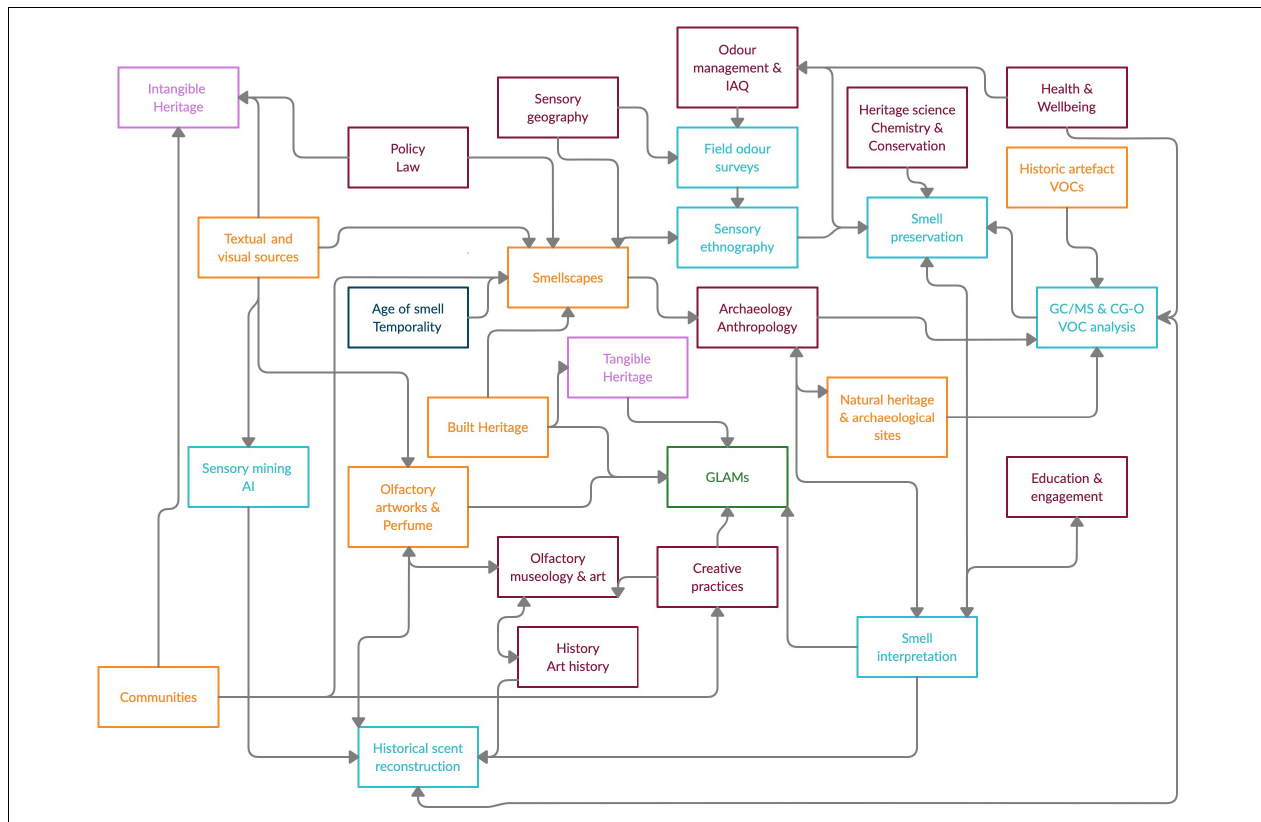
FIGURE 1 | Representation of olfactory heritage as a system, encompassing competences, materials and meanings. The colours indicate dimensions, as follows: maroon: disciplines and knowledge domains; blue: competences and skills; orange: materials, resources and technologies; navy: time; green: environment: purple: heritage approaches. Arrows represent communication and relationship